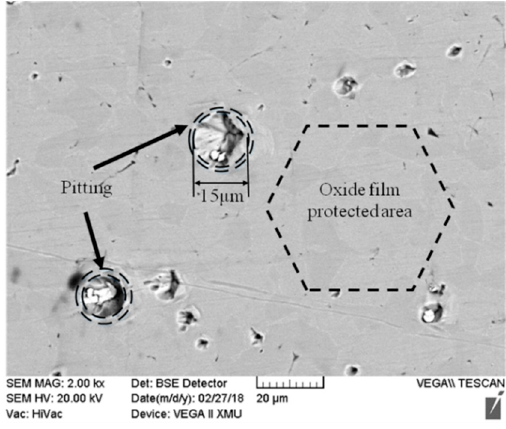
Figure 6. SEM image of Ti-6Al-4V titanium alloy after salt spray corrosion for 576 h.